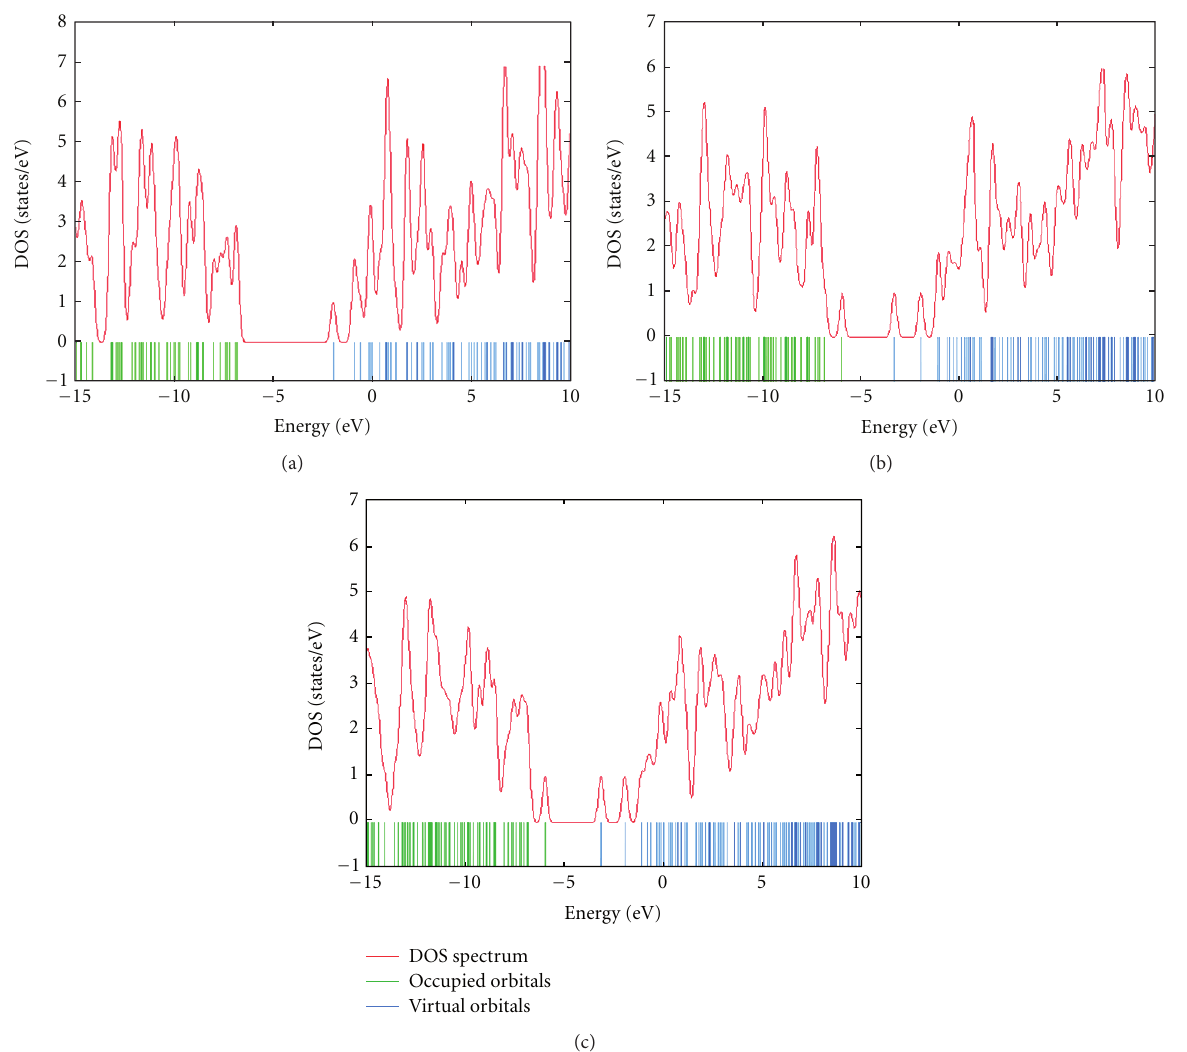
F 4: e density of states (DOS) of (a) pure model, (b) and (c) diborinin-doped